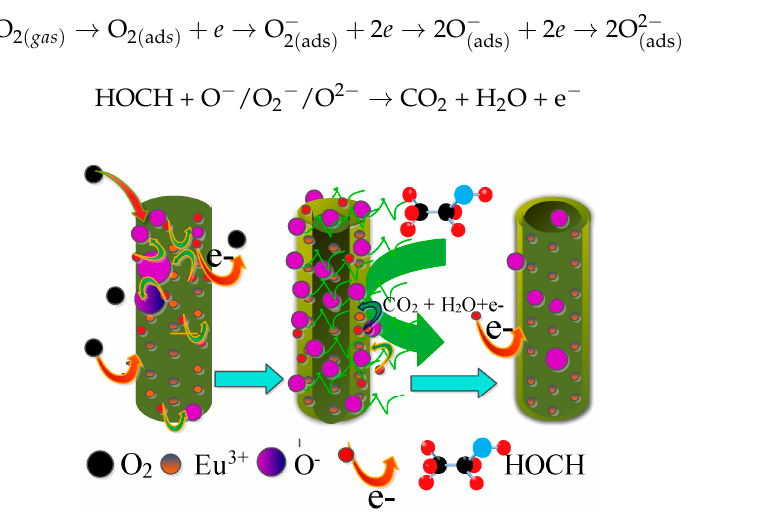
Figure 13. Schematic illustration of the gas sensing mechanism of the Eu-doped SnO 2 nanoarry sensors.